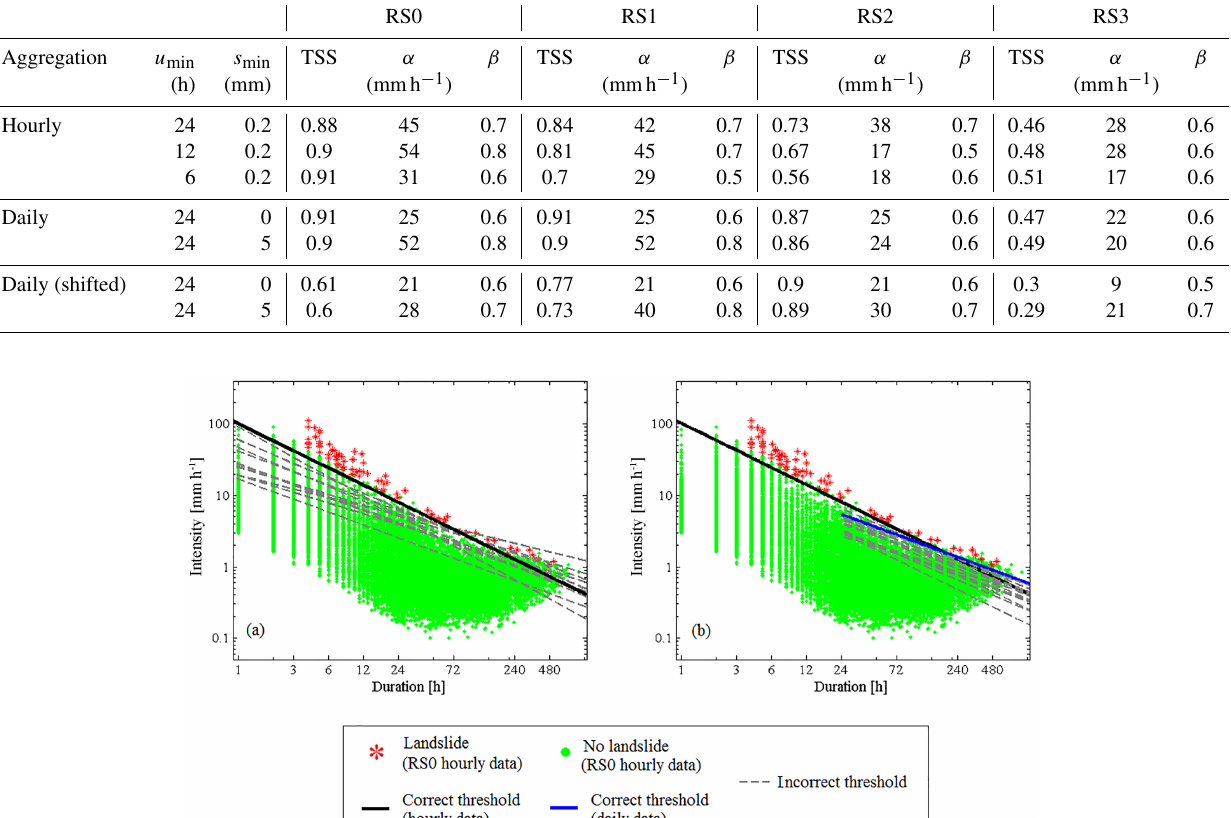
Table 7. Threshold calibration results for all simulations, when antecedent precipitation memory is present ( τ M = 2 . 75 days).